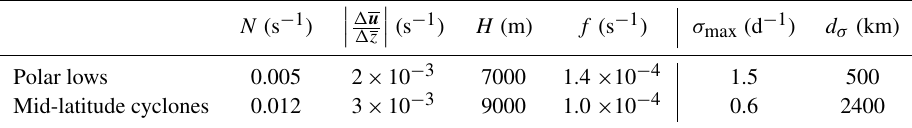
(cid:12) (cid:12) (cid:49) u (cid:12) (cid:12) (cid:12) (cid:12) , from Fig. 4, and the tropopause (cid:49)z